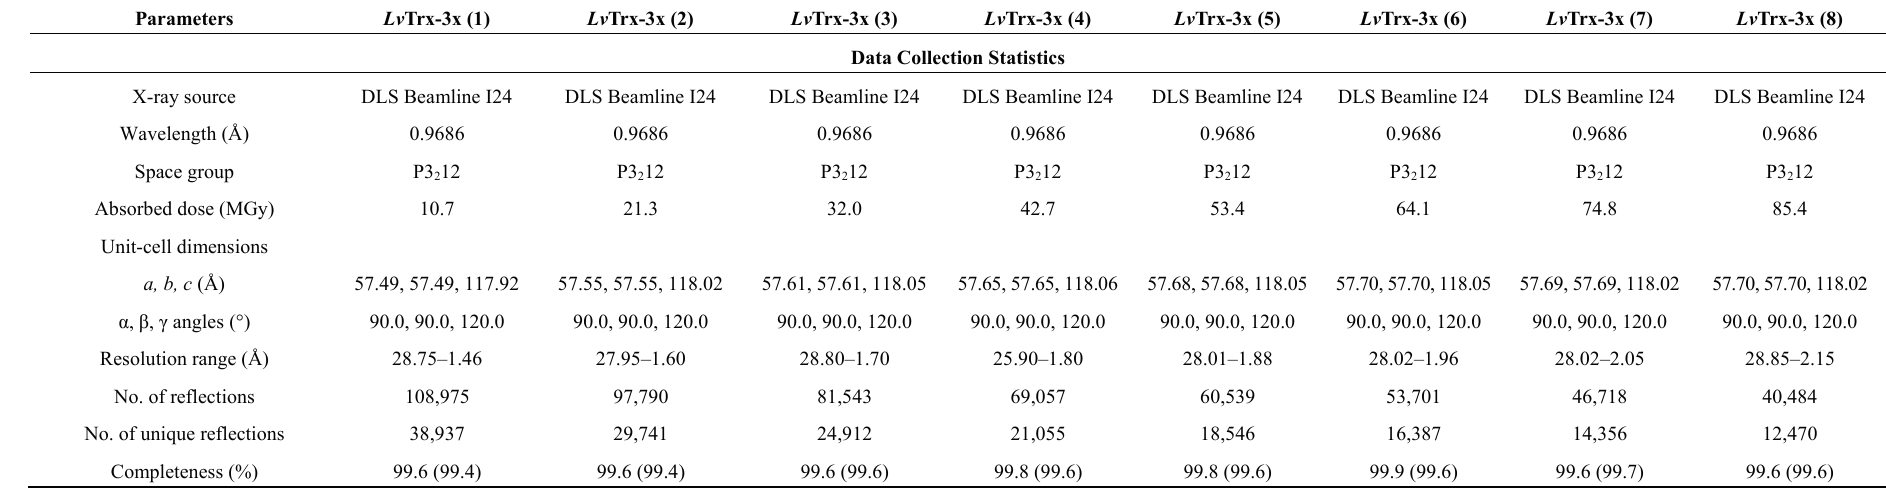
Table 2. Summary of crystallographic data of Lv Trx-3x. Values in parentheses are for the highest resolution